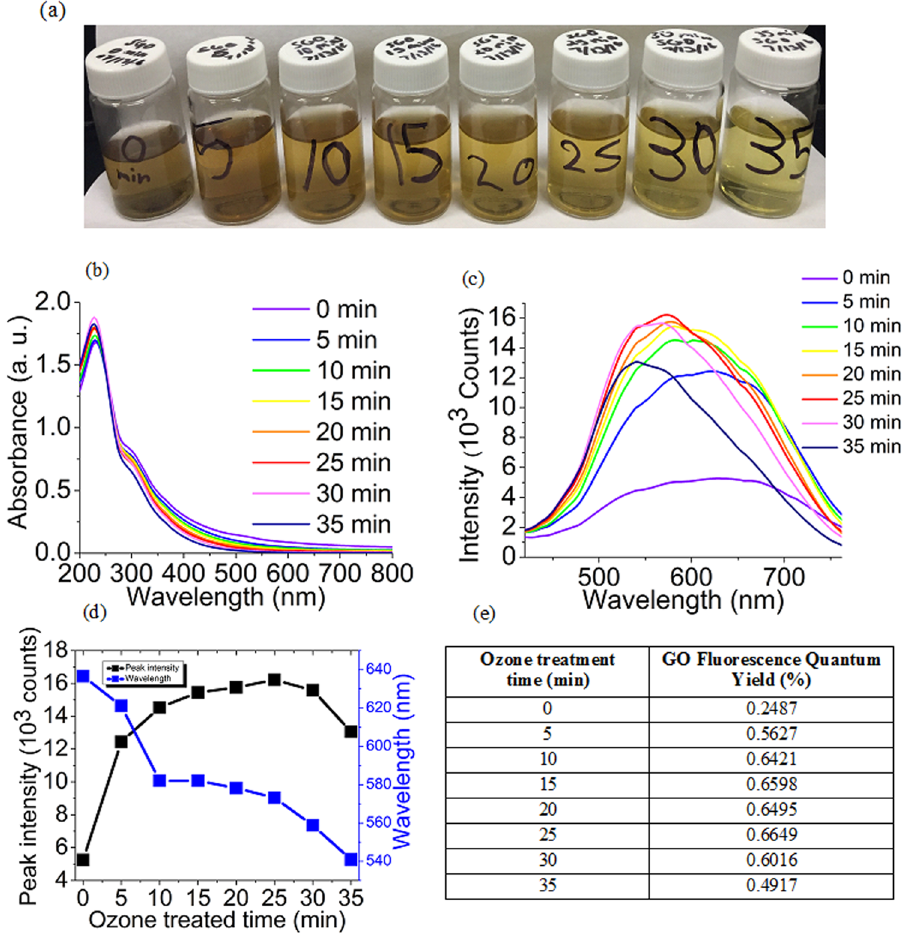
Figure 1. ( a ) Pictures of the ozone-oxidized GO samples with respective oxidization times (0, 5, 10, 15, 20, 25, 30, 35 minutes) ( b ) Absorption spectra of 0 to 35 min ozone-treated GO ( c ) Fluorescence spectra of 0 to 35 min ozone-treated GO ( d ) A plot of fluorescence intensity and maximum emission wavelength variation with ozone treatment ( e ) The table of GO fluorescence quantum yields at particular ozone treatment